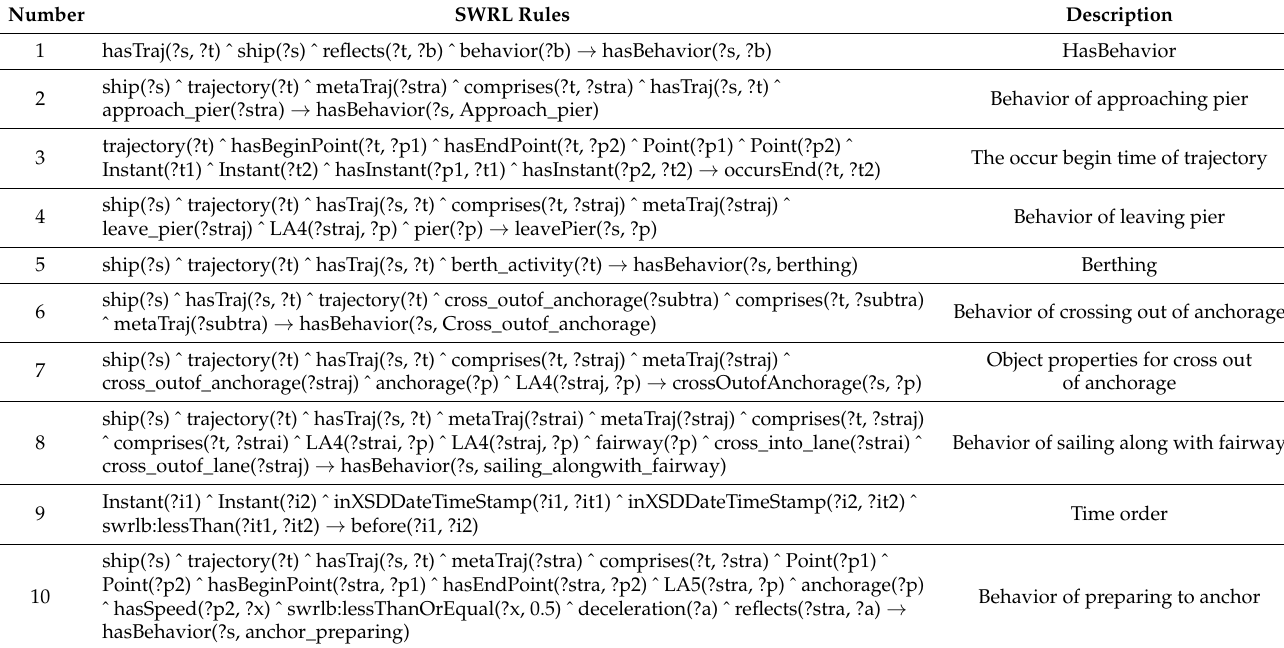
Table 1. Selected SWRL rules for reasoning about advanced